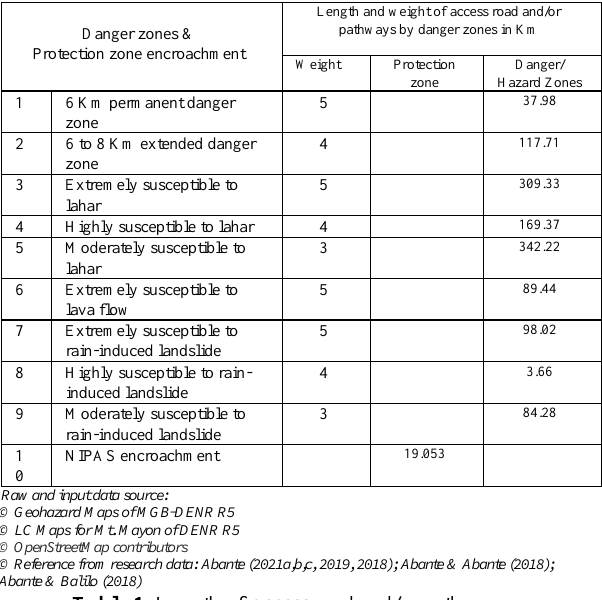
Figure 9 . Accessibility and OSM Building Nearness to